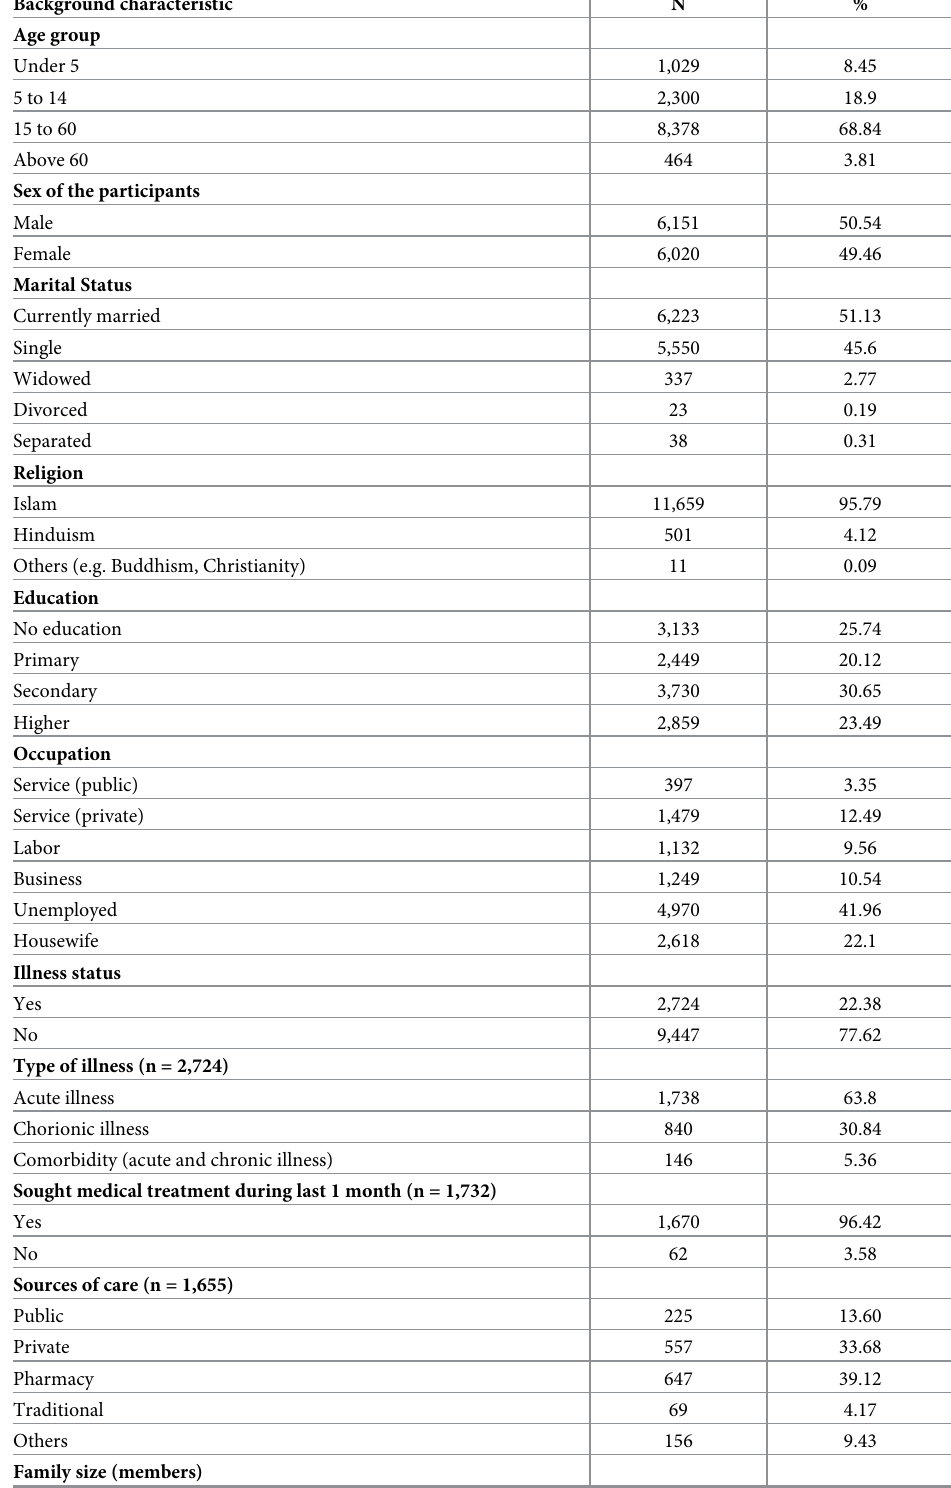
Table 1. Background characteristics of study